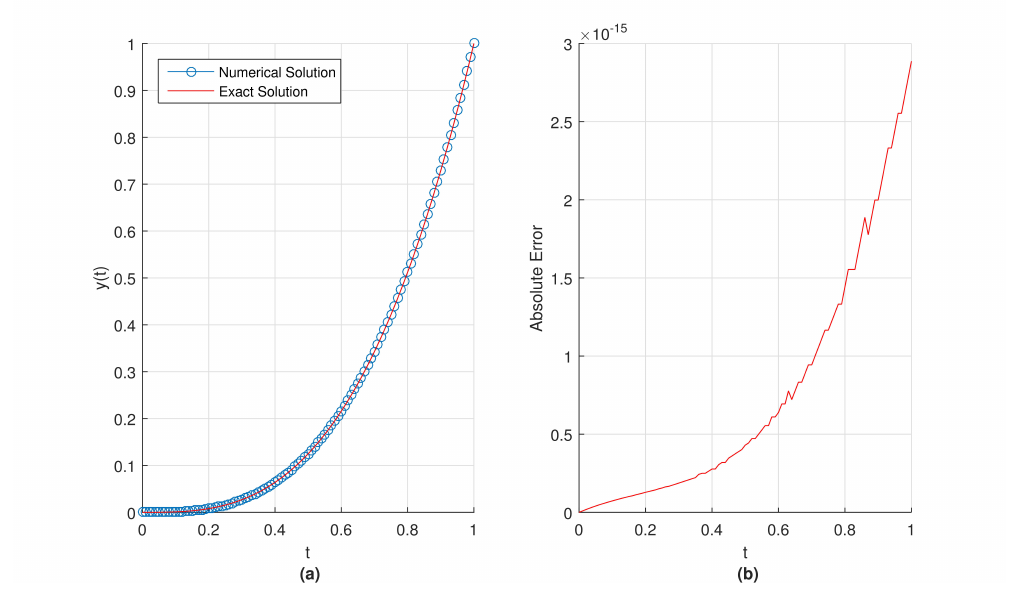
Figure 7. ( a ) The numerical and the exact solutions with m = 3. ( b ) The absolute error with m =